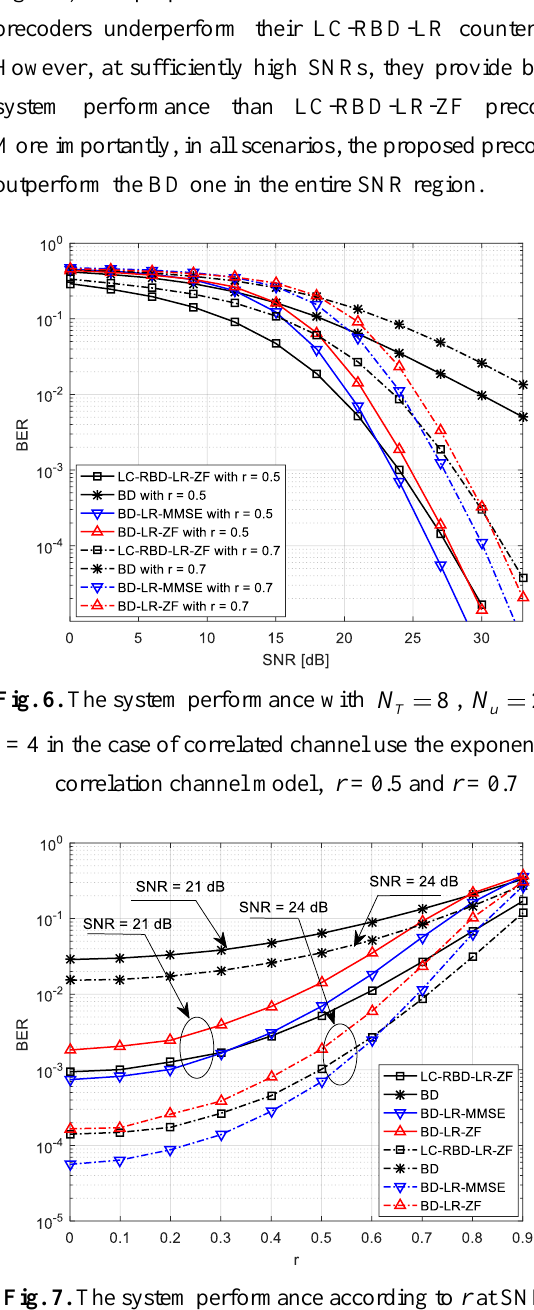
Fig. 7. The system performance according to r at SNR = 21 dB and 24 dB with Fig. 7 illustrate the BER curves of all precoders as functions of r at SNR = 21 dB and 24 dB.